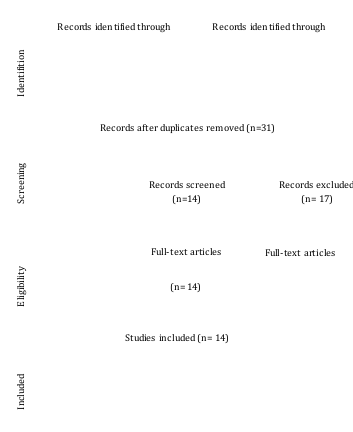
Figure 1. Flow diagram showing the